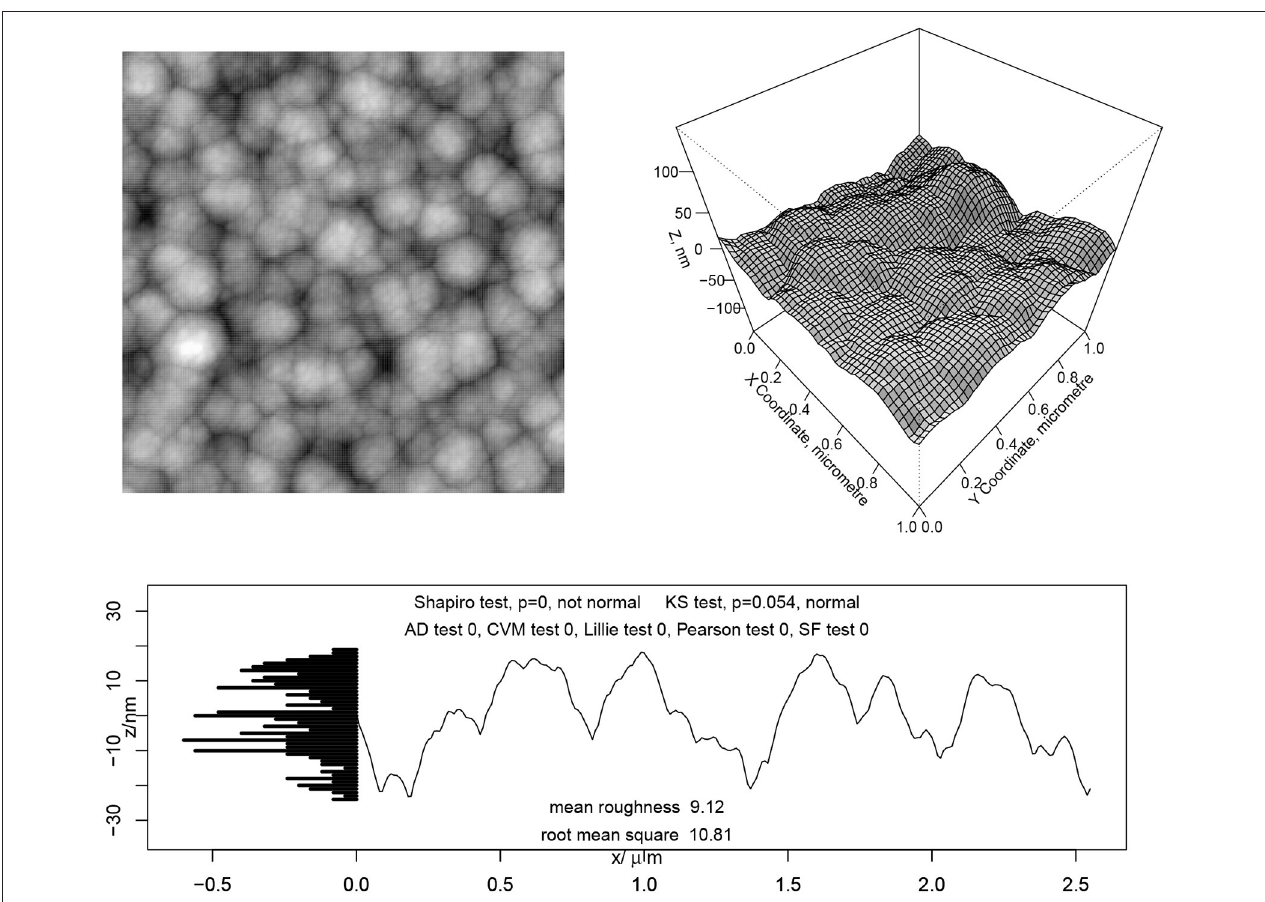
FIGURE 8 | The AFM scan with 10 nm step of the a-C sample after profilometer measurements. (Left) full measured patch 2.56 x 2.56 µ m . (Right) extracted small region 1 x 1 µ m . (Bottom) A typical profile with normality tests and two descriptive statistics (values are in nm): the root mean square (rms) and the mean roughness. The cauliflower-like structure can be clearly